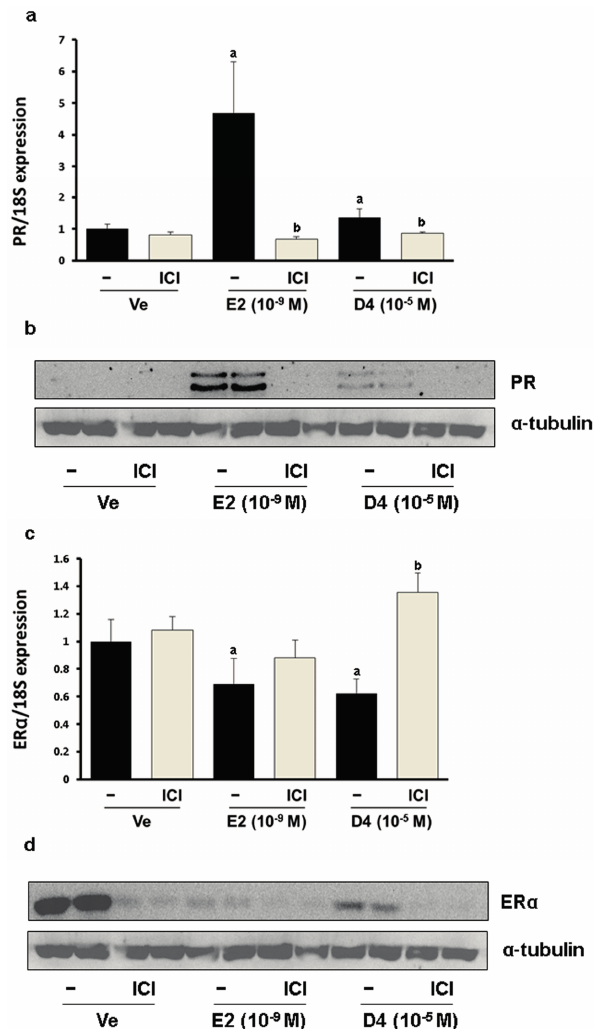
Figure 2. PR expression in GH3 cells at the mRNA ( a ); and protein ( b ) levels; ER α expression in GH3 cells at the mRNA ( c ); and protein ( d ) levels. Results presented in the bar graph are divided according to chemical administered and subdivided according to the presence or absence of ICI 182 780 (shown as ICI). a p < 0.05 versus vehicle; b p < 0.05 versus without ICI. Data are presented as the mean ±